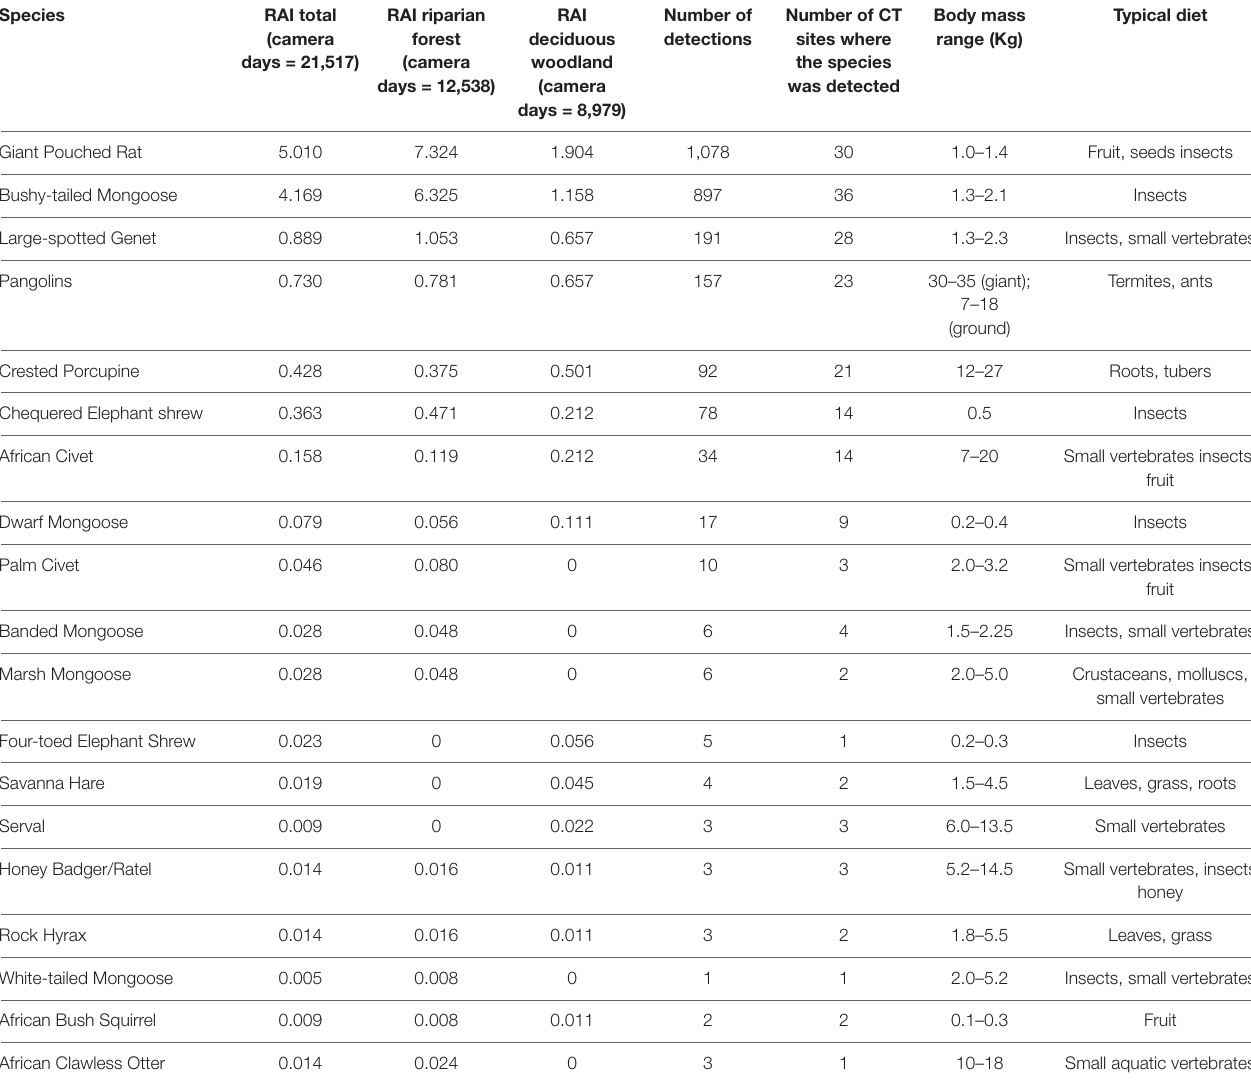
TABLE 1 | Relative Abundance Indices (RAIs) for the meso-mammal species ( n = 19) of Issa Valley, Tanzania. Species Number of CT